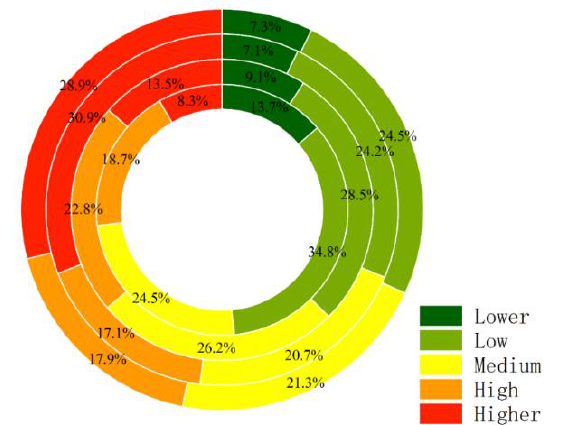
Figure 7. Area proportion of each level of landscape ecological risk(From the inner ring to the outer ring in the order of 2015, 2020, 2035 ND Scenario, 2035 LC